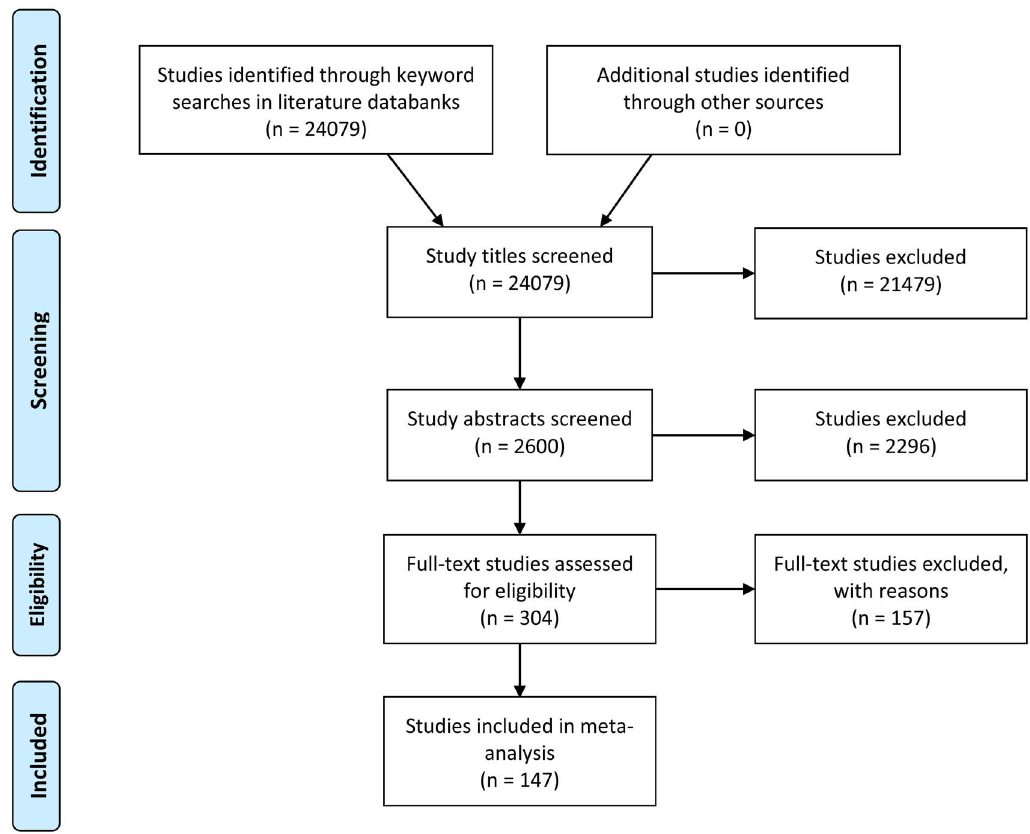
Figure 1. Selection of studies for inclusion in the meta-analysis.